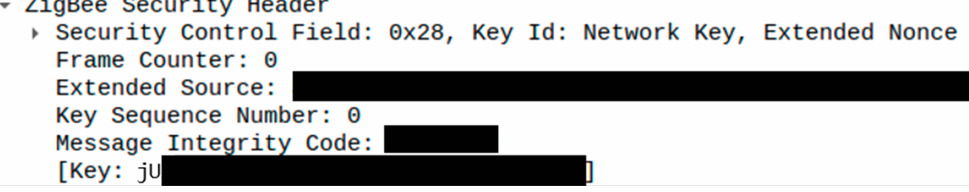
Figure 6. Decrypted ZigBee installation code on